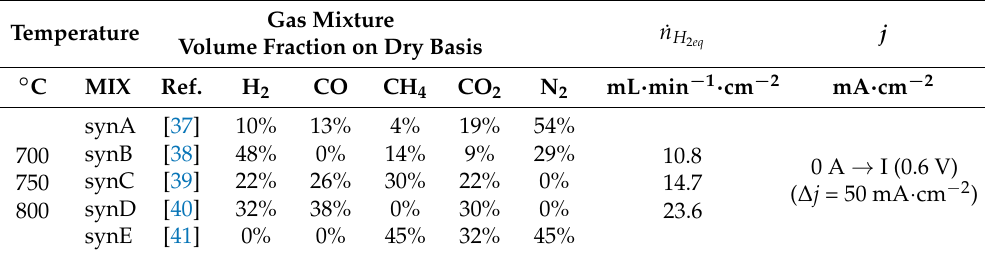
Table 3. Design of experiments set-points for process decision